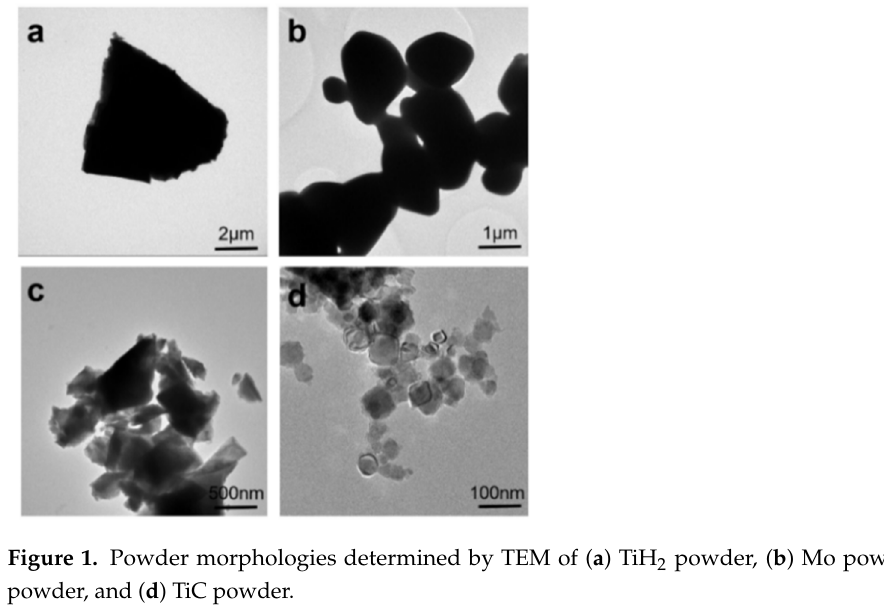
Figure 1. Powder morphologies determined by TEM of ( a ) TiH 2 powder, ( b ) Mo powder, ( c ) Zr powder, and ( d ) TiC powder.